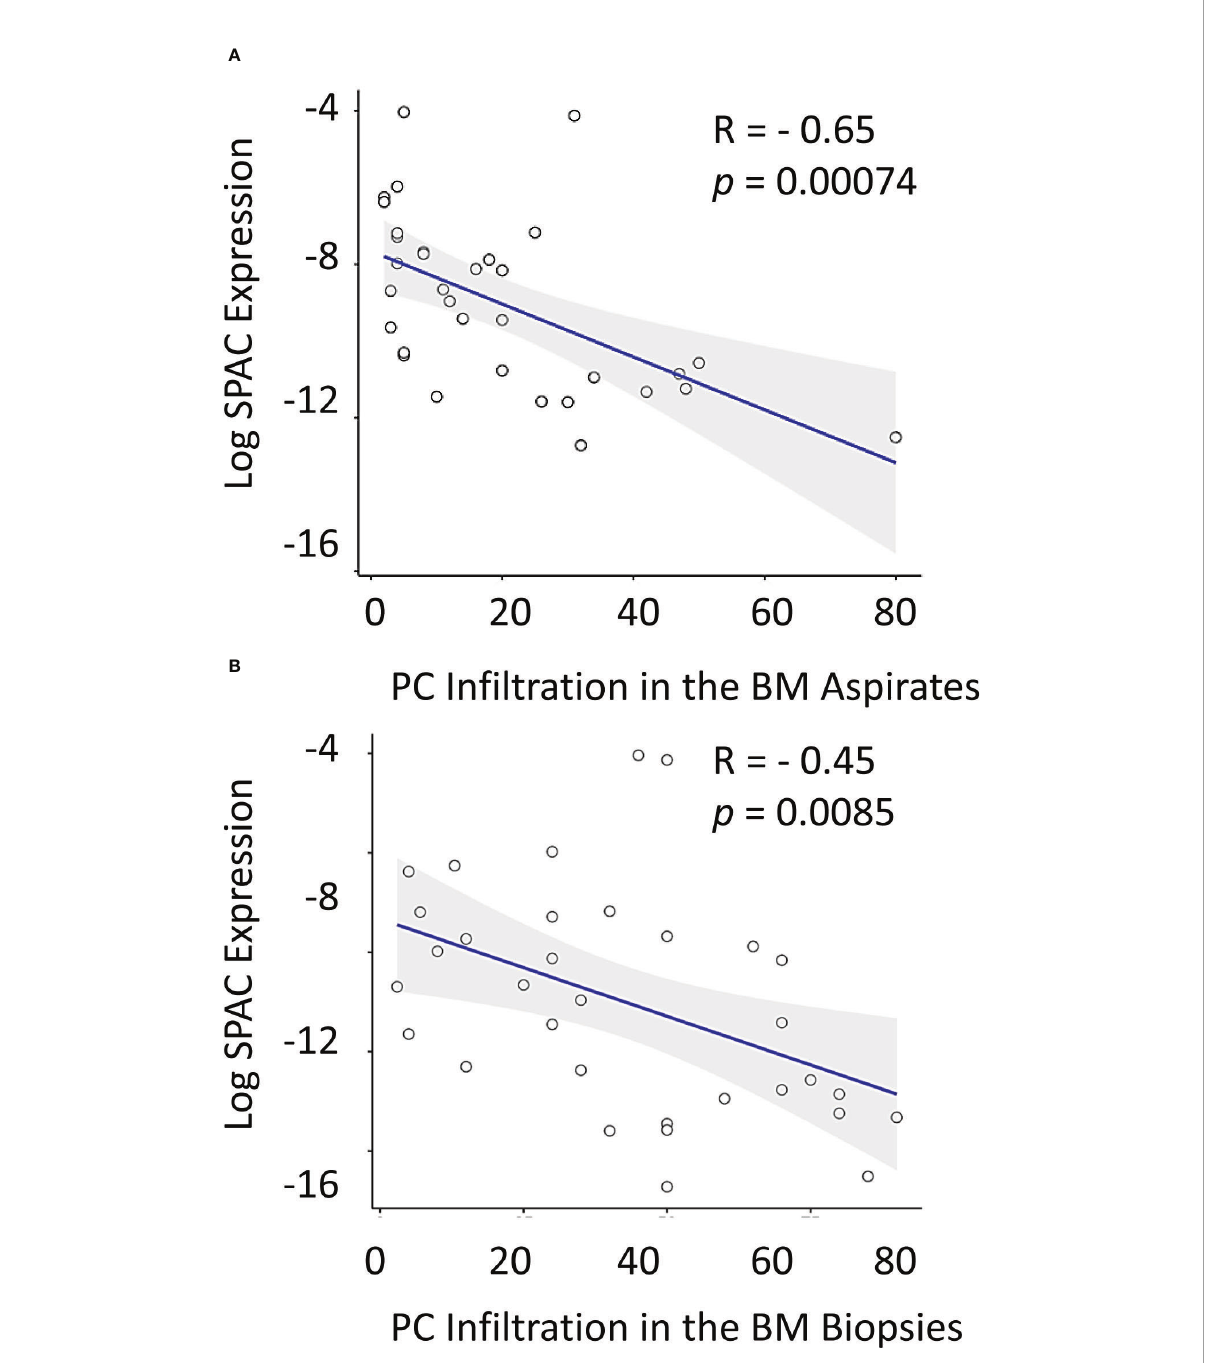
FIGURE 5 Correlation between log SPARC expression level and bone marrow plasma cell in fi ltration % in multiple myeloma patients at diagnosis. The y- axis represents the relative expression of SPARC to 18S after log transformation, whereas the x-axis represents the BM PC in fi ltration % in diseased MM patients ’ (before treatment) in BM aspirates (A) and BM biopsies (B) . Pearson r correlation revealed a statistically signi fi cant inverse correlation between log SPARC expression levels and BM plasma cell in fi ltration % in MM patients (n = 33) at their initial diagnosis; BM aspirates with P-value= 0.00074, and r = -0.56, BM biopsies with P -value = 0.0085, and r = - 0.45. Linear regression is shown as a solid